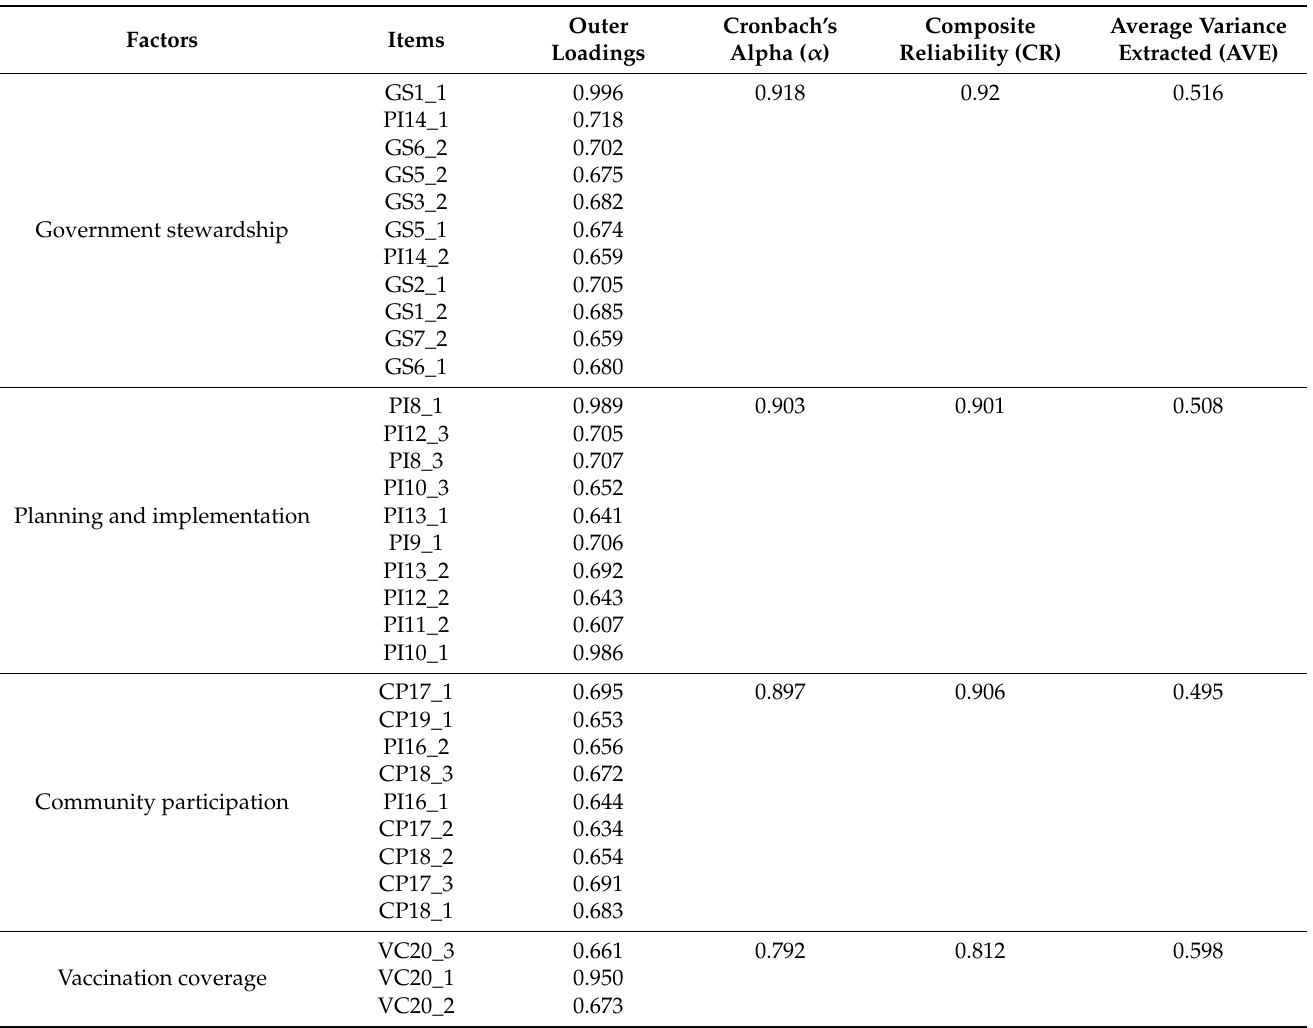
Table 4. Outer loadings, Cronbach’s alpha, CR, and